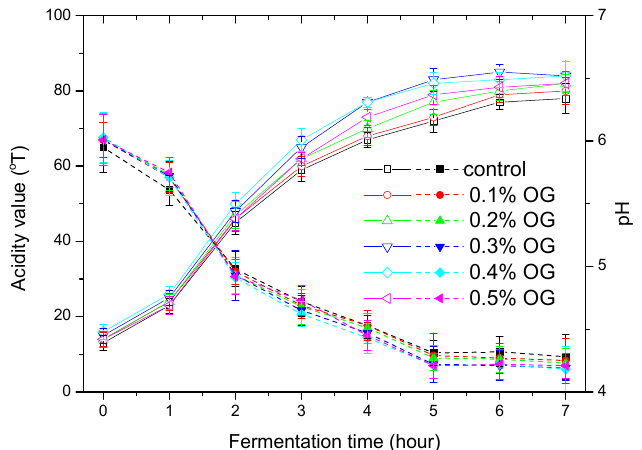
Figure 5. Changes of titrated acidity and pH during fermentation of set-type yogurt with and without OG addition.